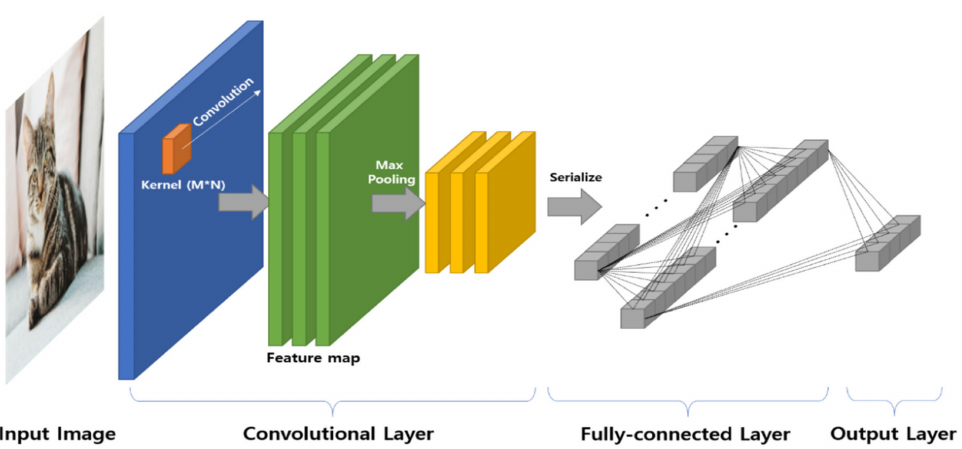
Figure 2. General structure of CNN for image classification.